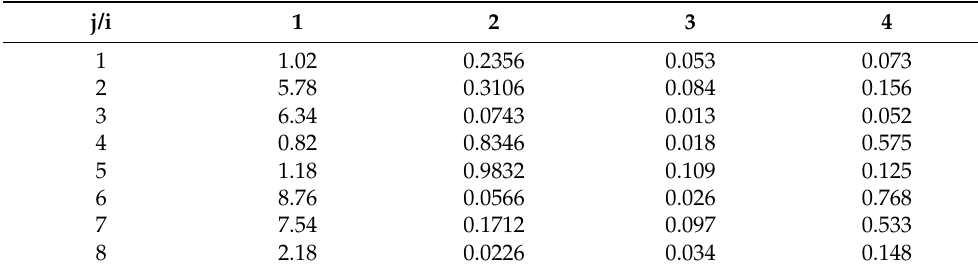
Table 2. Subsequent parameters described by Nusselt modeling